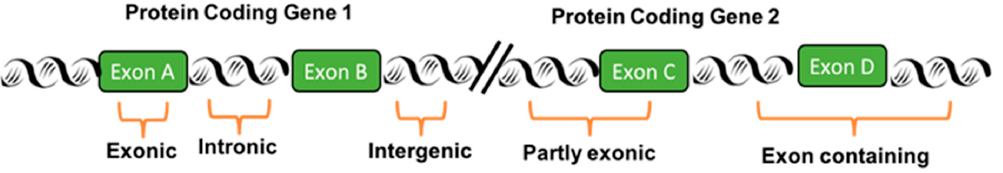
Figure 1. Types of ultra-conserved regions (UCRs). A schematic representation of the different types UCRs as per their genomic location with respect to their protein-coding of UCRs as per their genomic location with respect to their protein-coding genes.